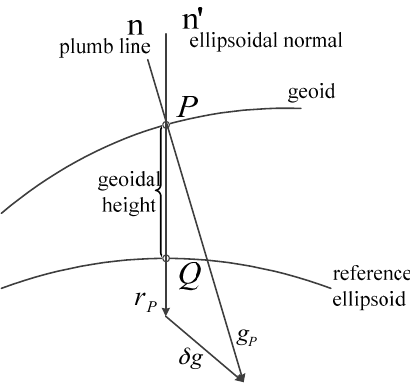
Figure 1. Description of the gravity disturbance vector.